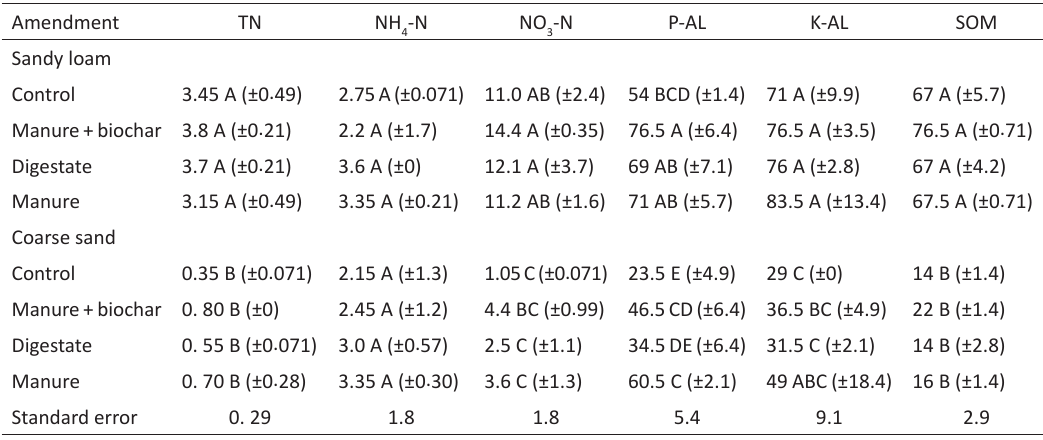
Table 6. Amount of Kjeldahl nitrogen (TN) (g kg -1 DM), NH4-N (NH available phosphorus (P-AL) and potassium (K-AL) (mg kg -1 DM), and soil organic matter (SOM, g kg -1 DM) in the Særheim plots that received different amendments in March 2019 (±1 standard deviation for each amendment and soil combination is given within parenthesis). Different letters within columns indicate statistically significant differences ( p